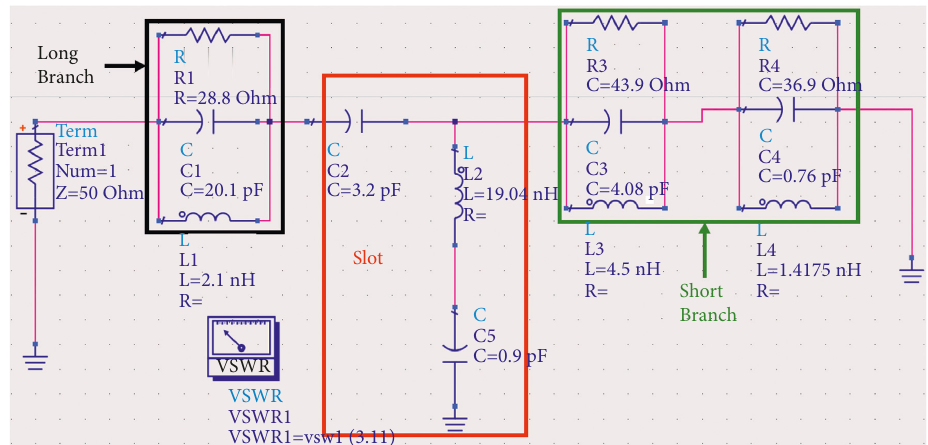
Figure 3: Equivalent circuit model of the antenna is reproduced from Alibakhshikenari et al. 2018.